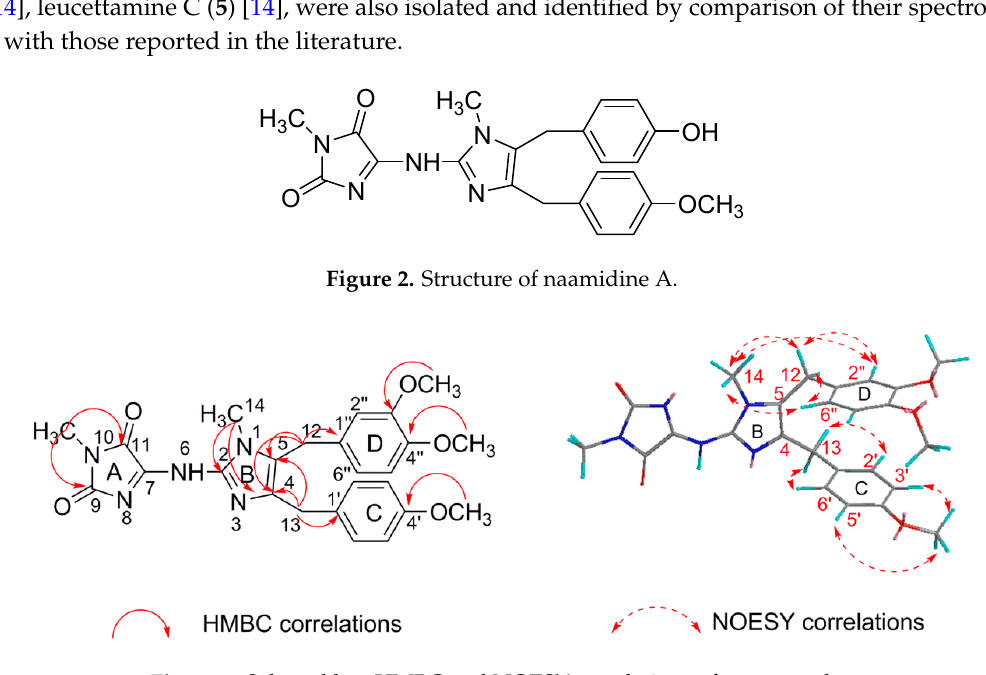
Figure 3. Selected key HMBC and NOESY correlations of compound 1 . Table 1. The 1 H- and 13 C-NMR data a for 1 b and naamidine A c .